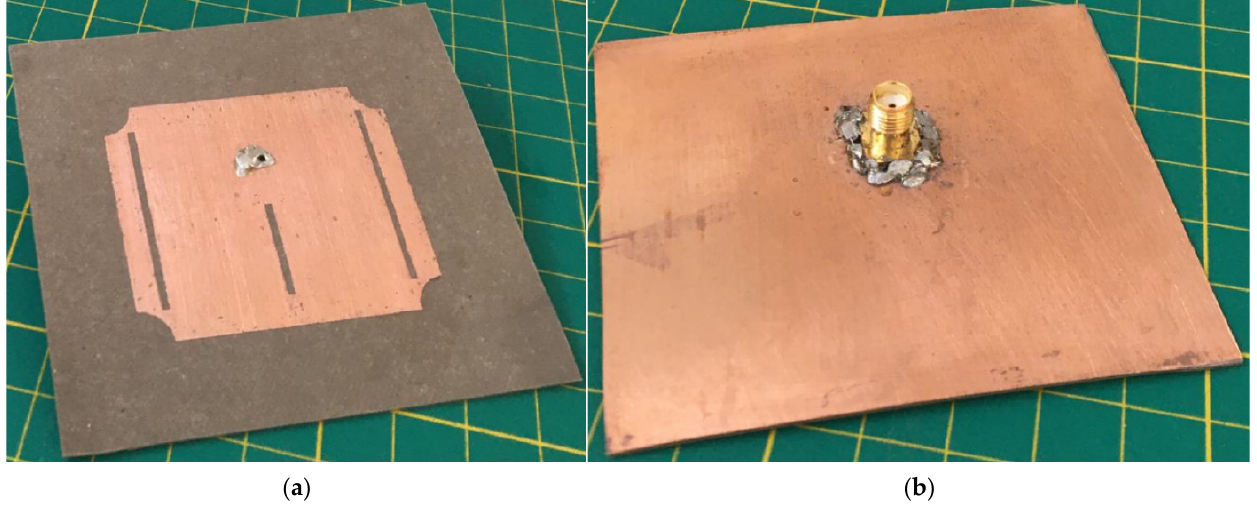
Figure 8. Implemented MPATSAT: ( a ) Top view; ( b ) Bottom view. A comparison of |S11| plots of the simulation and measurement results is given in Figure 9. It can be observed that the simulation and measurement results coincide with each other approximately. The difference between simulation and measurement is due to measurement and implementation errors. The measured maximum antenna gains at the measured resonance frequencies are 3.1 dB, 3.8 dB, and 7.1 dB, respectively.